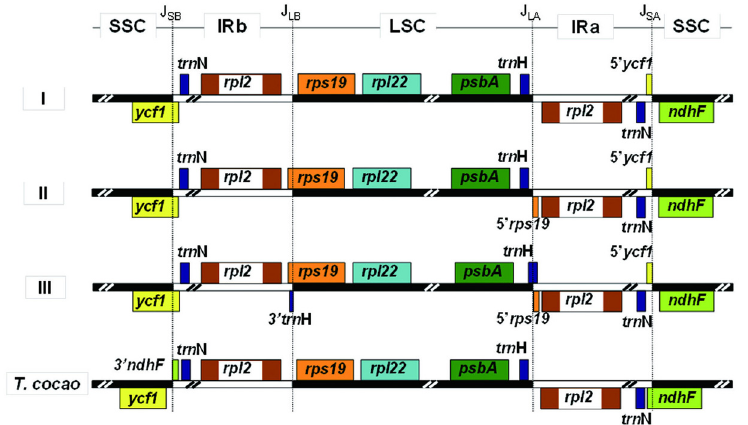
Fig 3. Three types of junction region models for Gossypium chloroplast genome. Type I , rps19 and trnH , entirely located in LSC region with no any overlap fragments in IR region. Type II , rps19 across the point of J LB , part fragment of 5 ’ rps19 located in IRa region, trnH perfectly located in LSC region. Type III , rps19 across the point of J LB and trnH across the point of J LA , part fragment of 5 ’ rps19 and 3 ’ trnH located in IRa and IRb region, respectively. Also see S1 Fig for phylogenetic placement of each IR junction